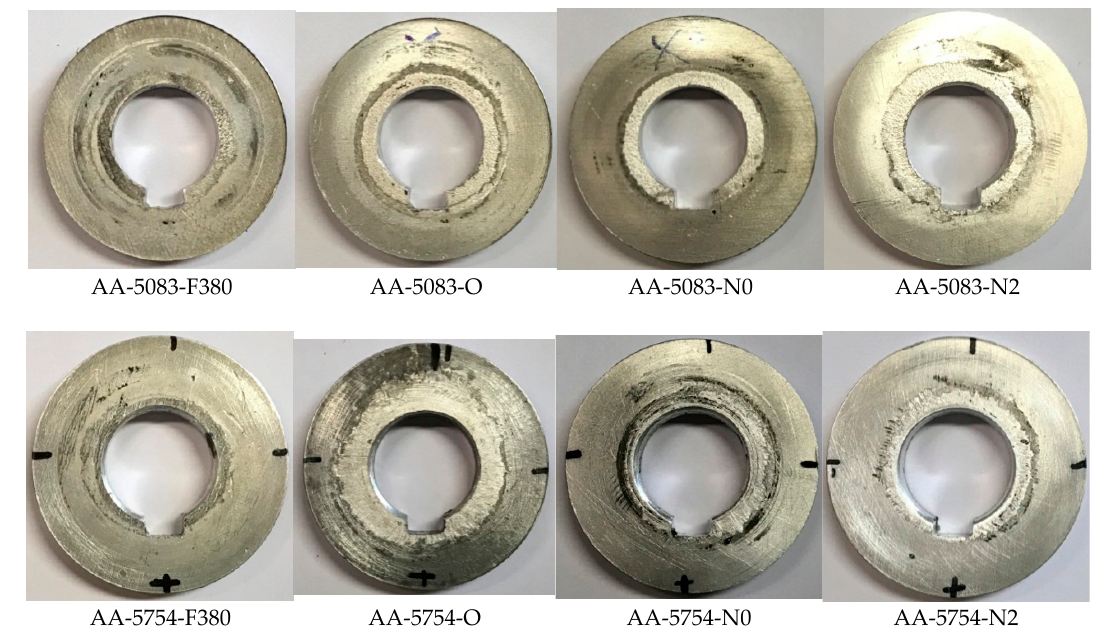
Figure 12. Disks after the wear tests.